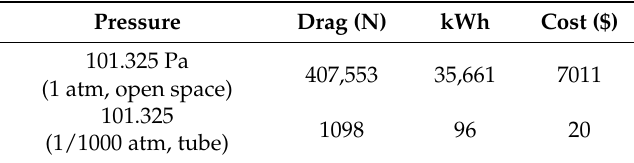
Table 2. Energy cost comparison between the control case (101.325 Pa with open space) and 101.325